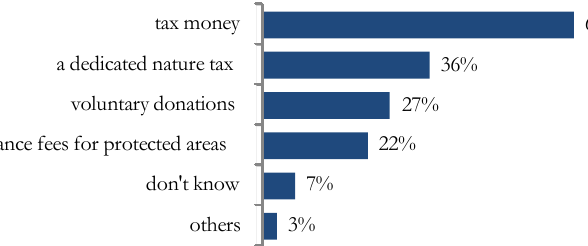
Figure 10: Types of payments for nature conservation accepted by visitors (n=308)